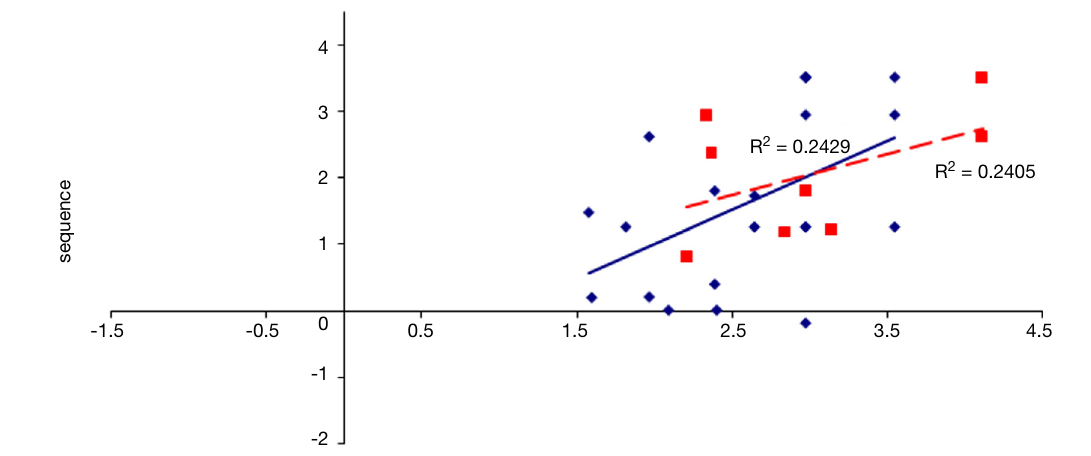
Figure 14 | Scatter plot of performance on the item and sequence tasks with linear fi t and R -squared values for control (Experiment 1, in red squares and dashed line) and college-age (Experiment 3, in blue circles and solid line) participants. The correlation is signifi cant in college-age